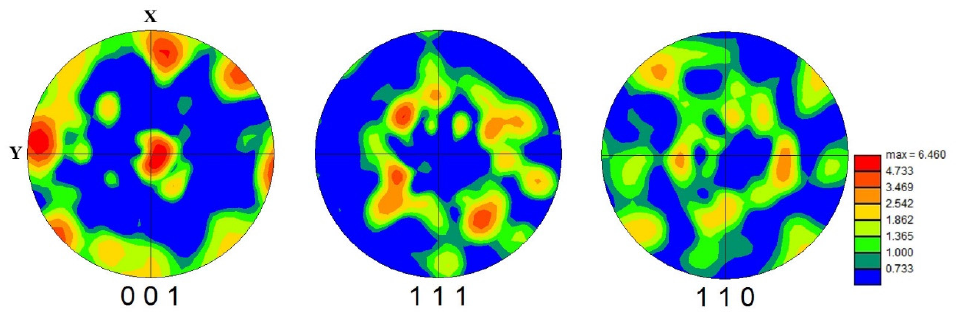
Figure 9. The EBSD pole figure (PF) maps of the β phase in sample